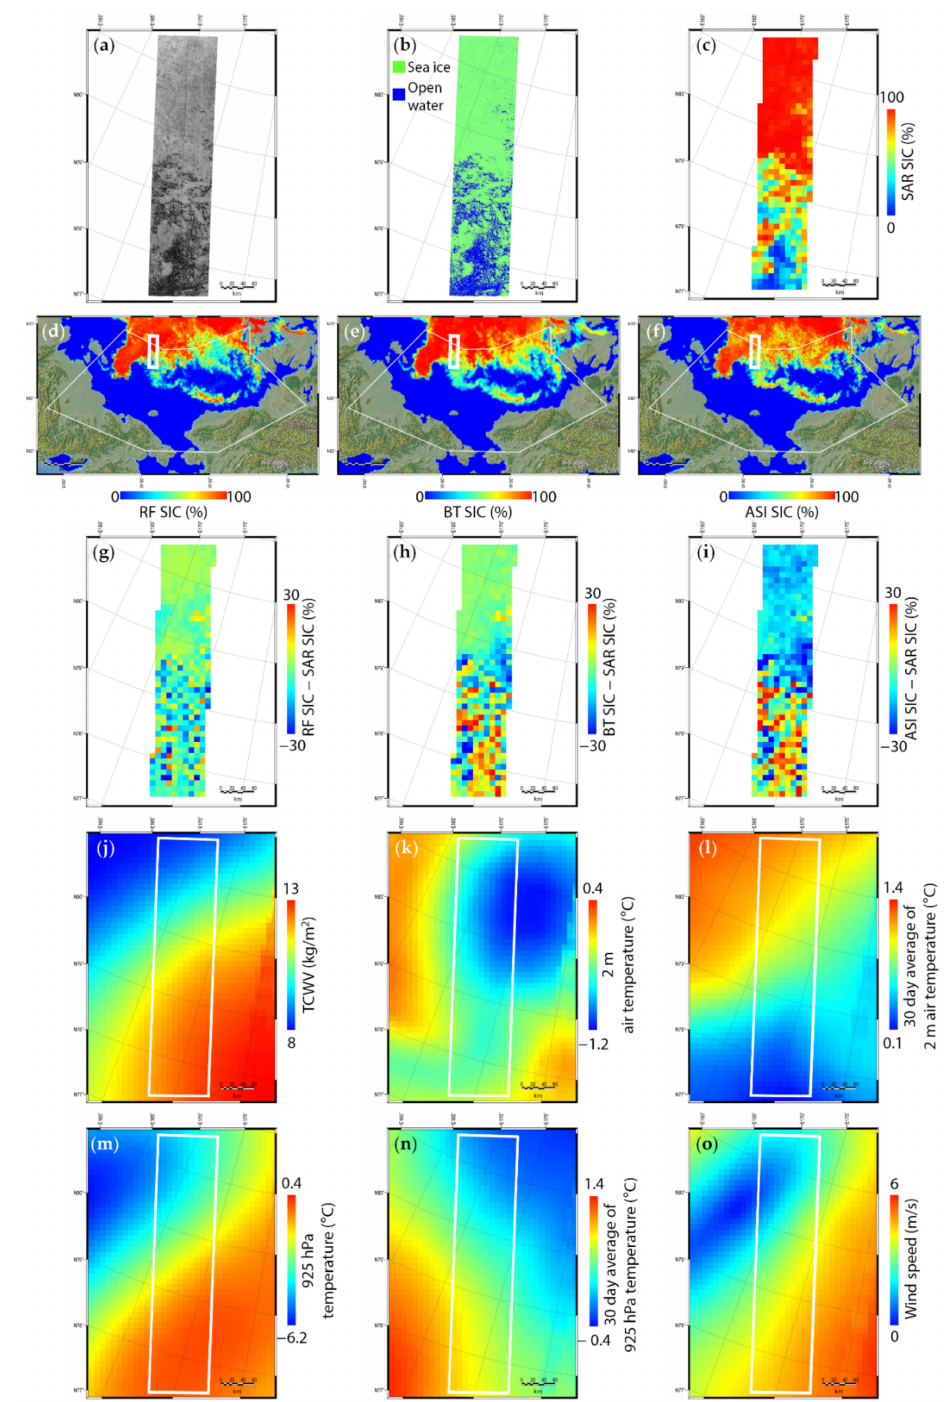
Figure 6. ( a ) KOMPSAT-5 EW SAR image acquired on 18 August 2015, and corresponding ( b ) ice/water map and ( c ) SIC with a grid size of 10 km. ( d – f ) RF, BT and ASI SIC map for the Pacific Arctic Ocean (the white polygon) on the same date as the SAR image. The difference between SAR SIC and ( g ) RF, ( h ) BT, and ( i ) ASI SIC for the same area of the SAR image (the white box in ( d – f )). For the same date, ( j ) TCWV, ( k ) 2-m air temperature, ( l ) 30-day average of 2 m temperature, ( m ) air temperature at 925 hPa, ( n ) 30-day average of air temperature at 925 hPa and ( o ) wind speed. The white box in ( j – o ) represents the area of SAR